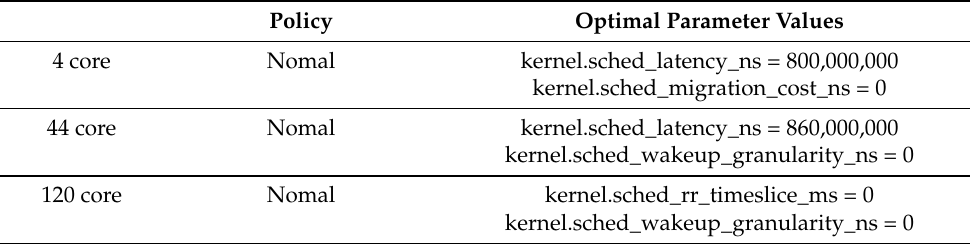
Table 3. STUN optimization results for Sysbench for each number of cores.